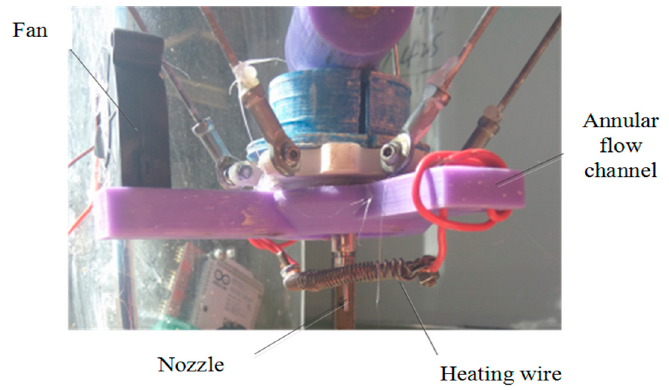
Figure 9. Device for in situ hot air flow drying.